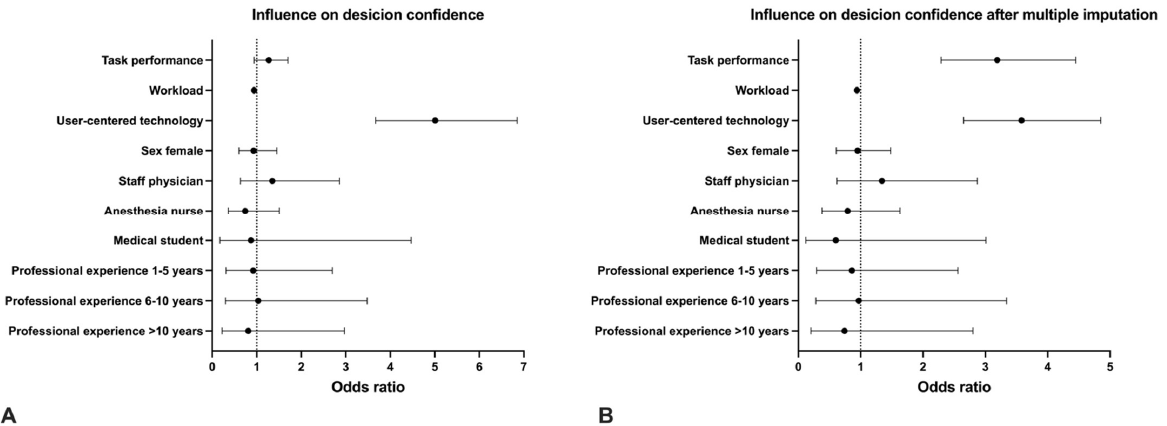
Figure 2. Results for mixed logistic-regression model. ( A ) including 2580 data points of 351 participants and ( B ) after multiple imputation to account for missing values, including all 3782 data points of all 421 participants. Presented bars are odds ratios with 95% confidence